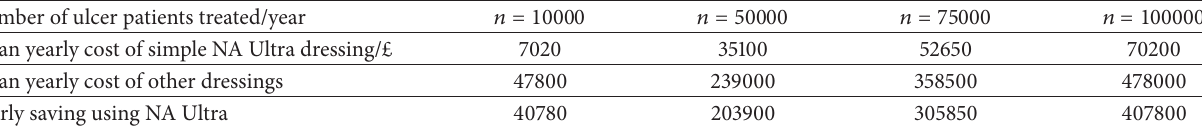
Table 5: The amount of money that can be saved depending on the number of ulcer patients treated per year.